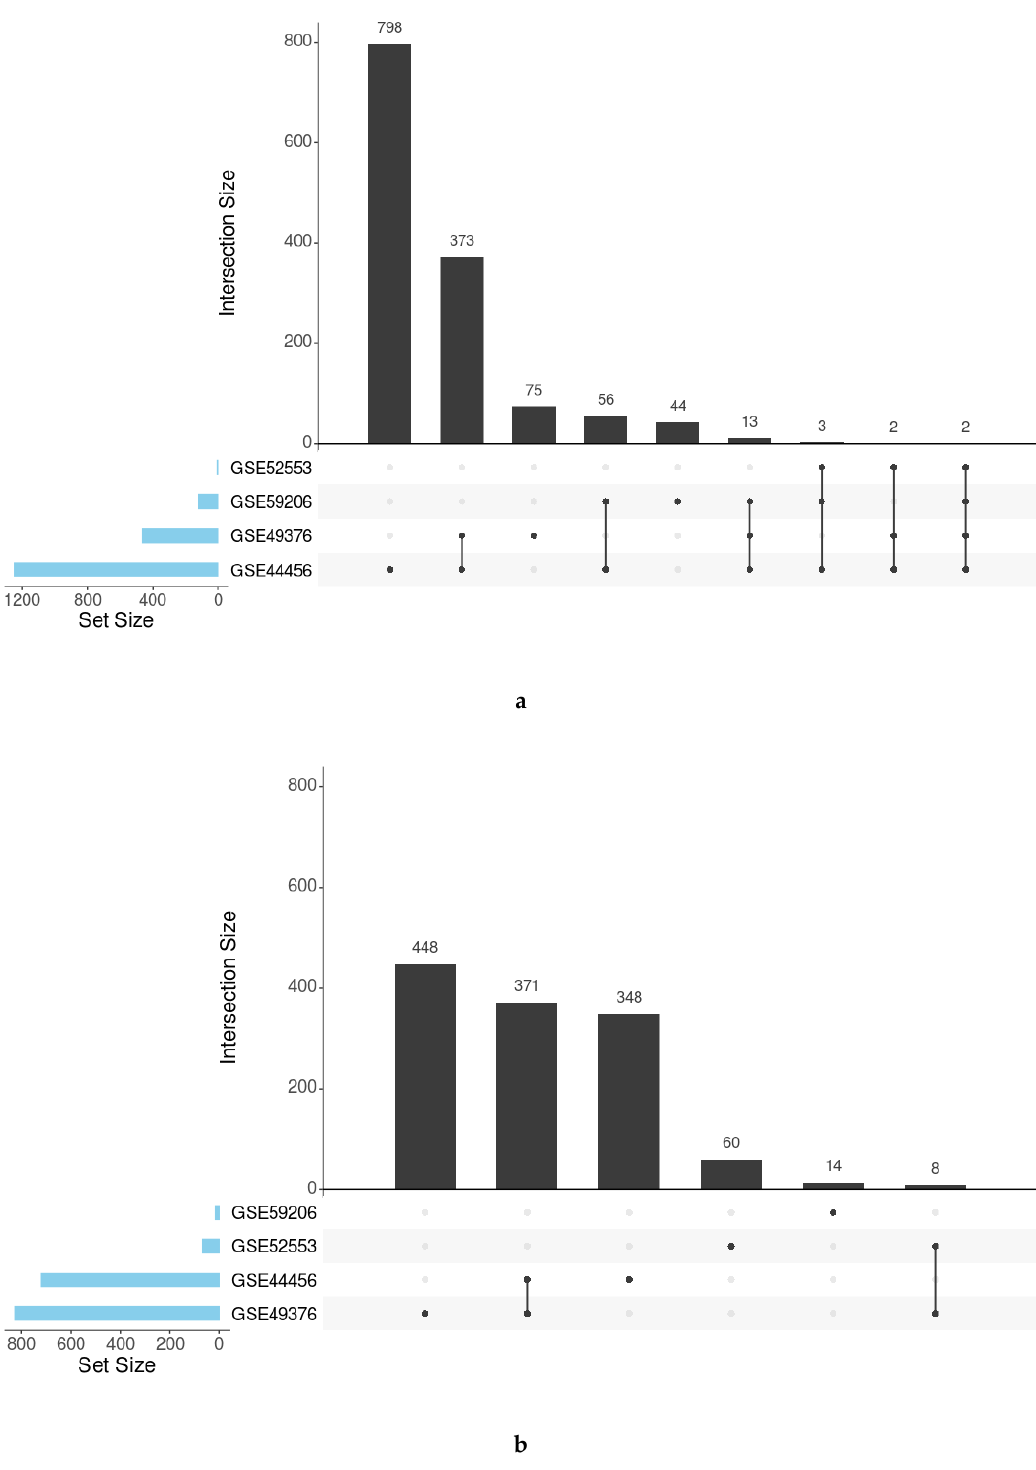
Figure 4. UpSet plots showing the number of common and specific GO functions in women ( a ) and men ( b ).